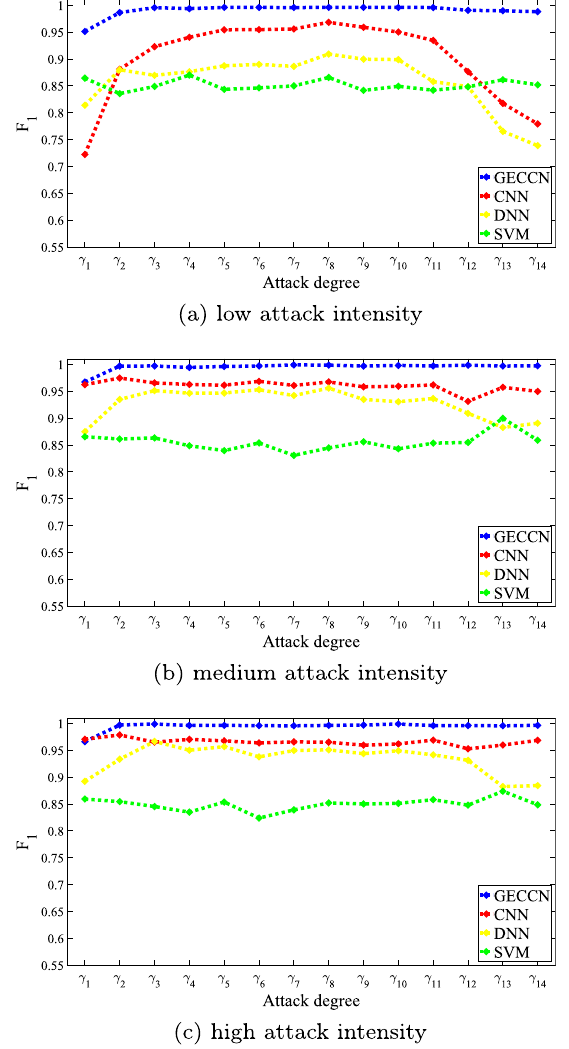
Fig. 7 Comparisons of different models in different attack degrees under a low, b medium and c high attack intensities